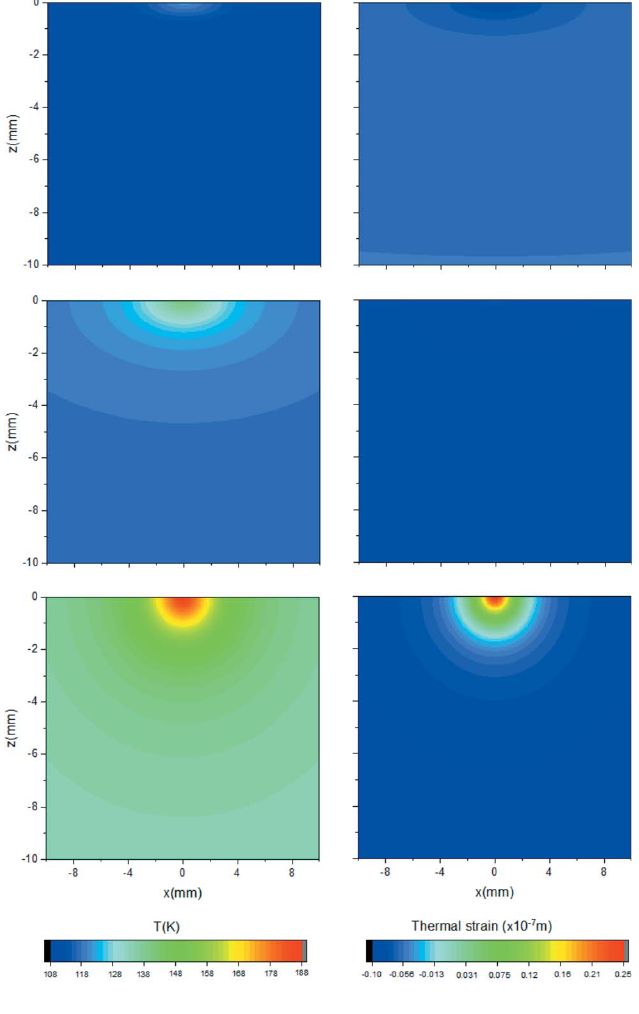
Figure 5 I16 Si crystal temperature and thermal strain calculated for different values of primary slit sizes, corresponding to P = 69 W, 116 W and 207 W (top to bottom) at fixed photon energy E = 3.5 keV. Left: temperature distribution. Right: thermal strain relative to 97 K (or P =